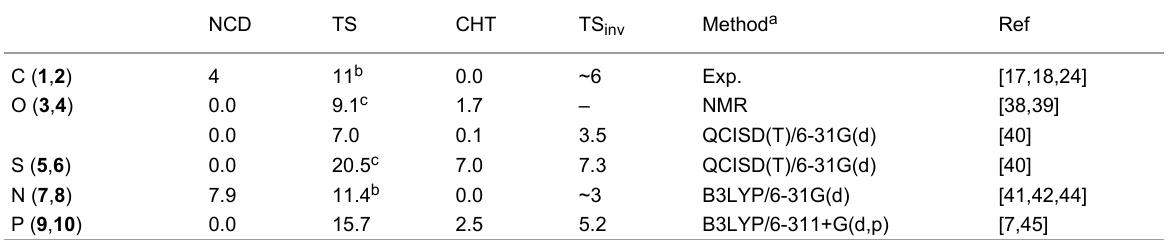
Table 1: Relative energies (in kcal·mol − 1 ) of the norcaradienes (NCD) 2 (C), 4 (O), 6 (S), 8 (N), 10 (P), the cycloheptatrienes (CHT) 1 (C), 3 (O), 5 (S), 7 (N), 9 (P), their interconversion barriers, and the barriers for ring inversion of the monocycles.